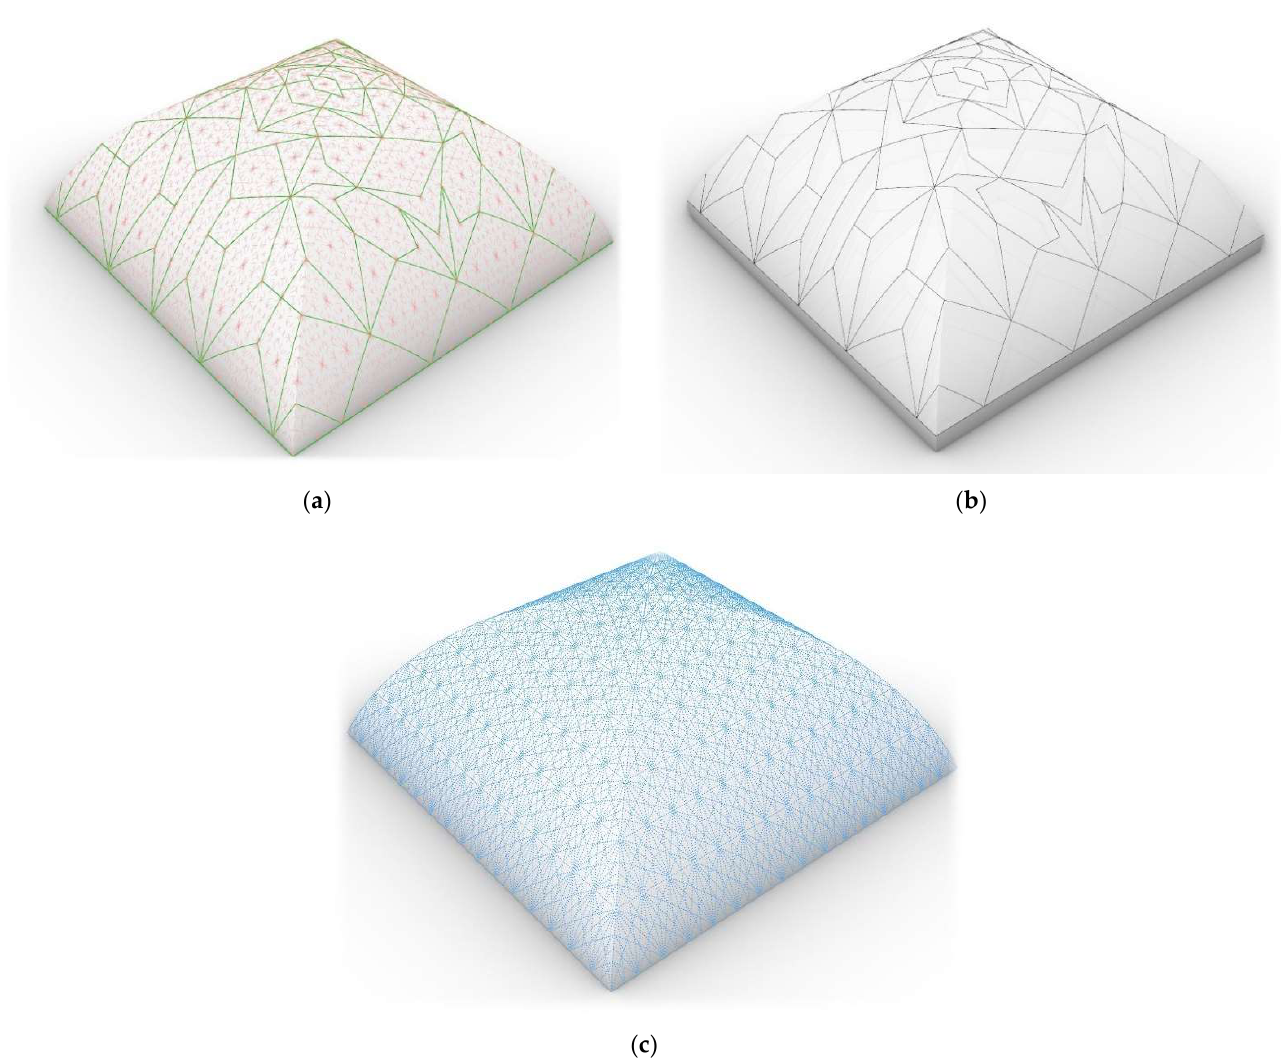
Figure 2. A pavilion vault with: ( a ) internal and peripheral interfaces at the boundary of the segments; ( b ) only peripheral interfaces; ( c ) a network of interfaces.